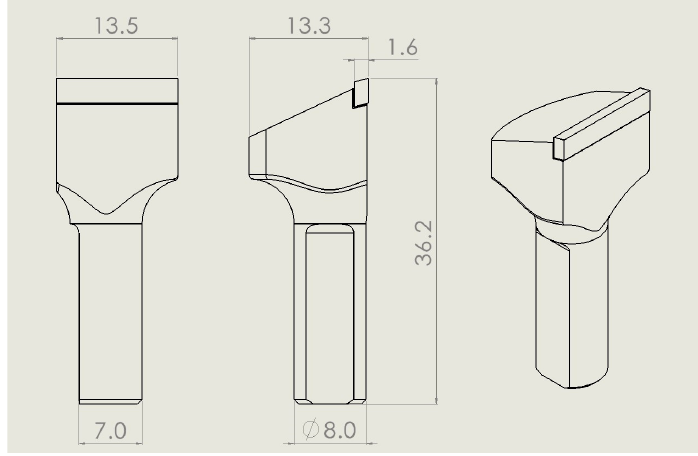
Figure 2. Schematic representation of the geometry of the RJS specimens geometry. Dimensions in millimetres.